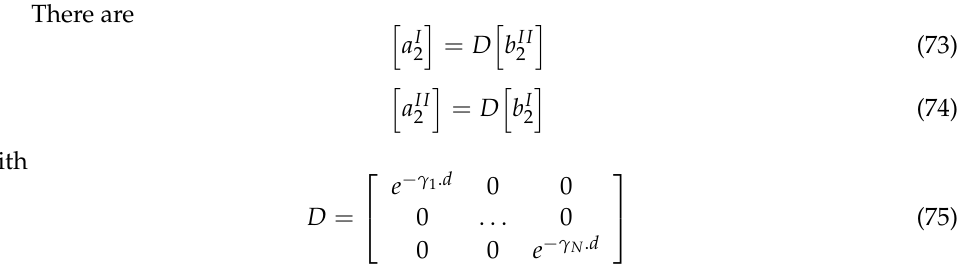
Figure 3. Cylindrical waveguide antenna filled with partially magnetized ferrite of width d with the same cross-section as the other waveguides.